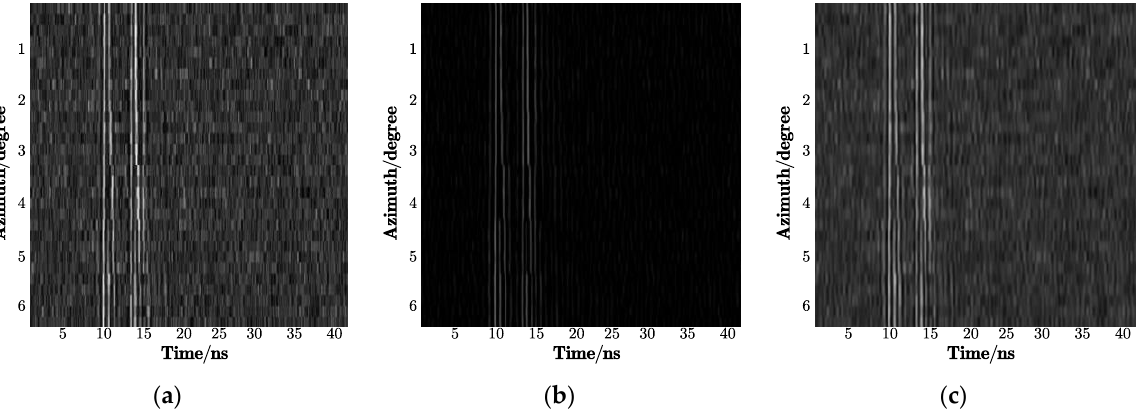
Figure 7. 2D echo signal: ( a ) the original echo with noise, where SNR equals − 2 dB; ( b ) decomposed mode BIMF2; ( c ) the sum of BIMF1 and BIMF2.